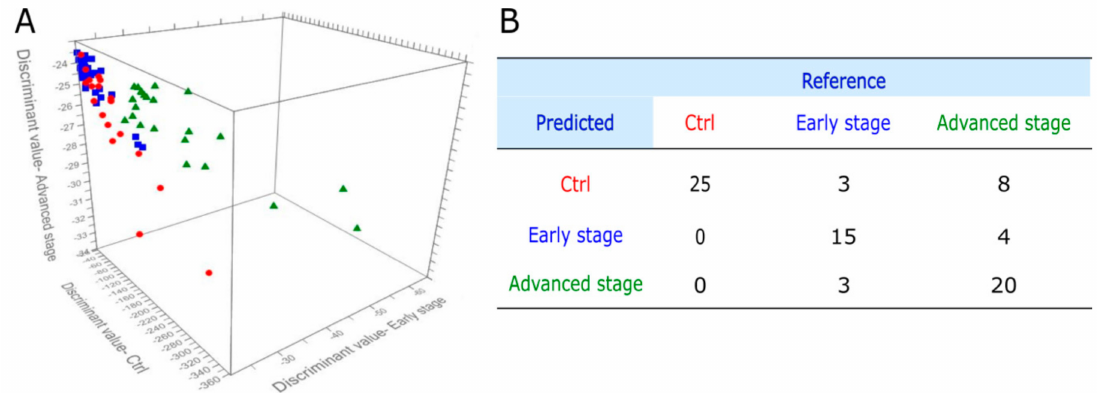
Figure 7. PCA-QDA model for cancer grading, obtained by combining CRP levels, hemoglobin levels, neutrophil counts and platelet counts with the SERS profiling of serum. ( A ) Prediction plot of the PCA-QDA of 25 control subjects (Ctrl), 21 patients with stage I or II gastric and colorectal cancer (early stage), and 32 patients with stage III and IV gastric and colorectal cancer (advanced stage), using the first seven principal components as input. ( B ) The confusion matrix of cancer grading yielded by the PCA-QDA on SERS spectra of serum and blood